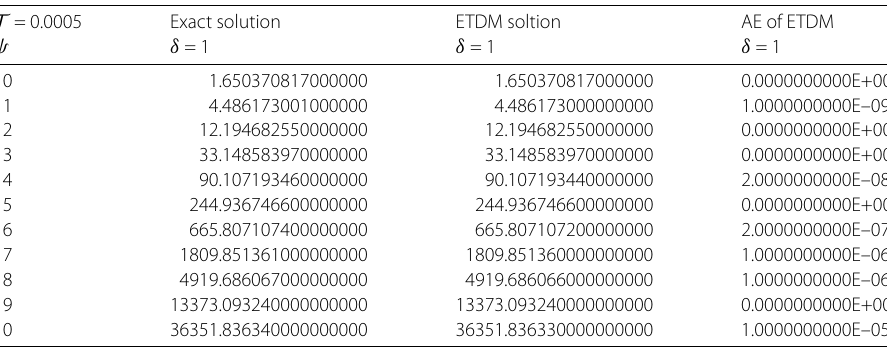
Table 4 ν ( ψ , ζ , T ) Comparison of Exact solution, ETDM and ETDM Error of example 1 at ρ = 1 T =